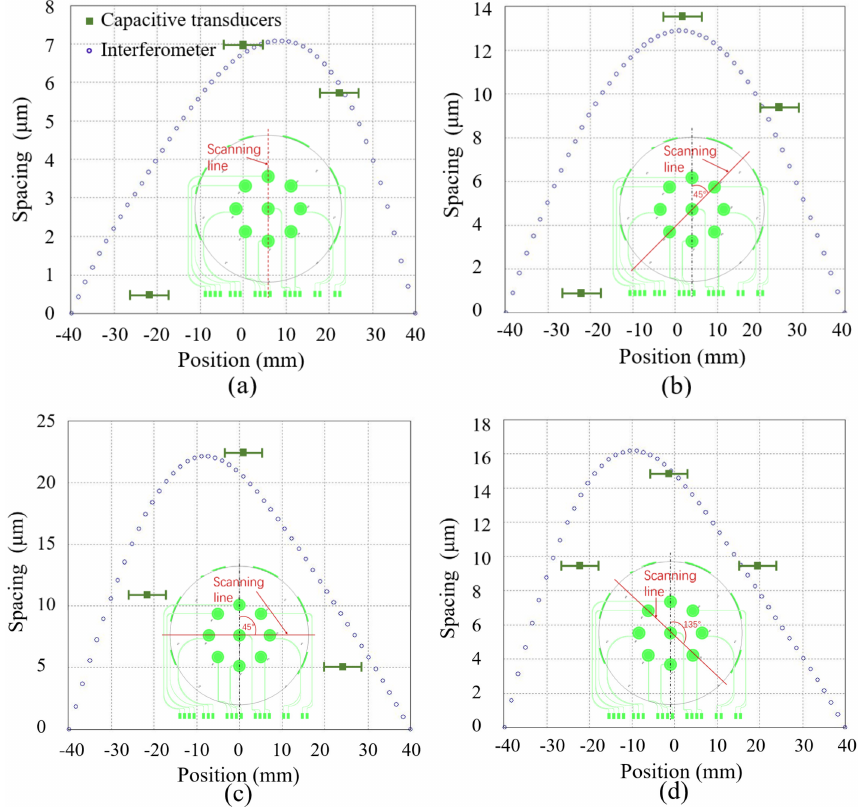
Figure 10. Measured wafer surface profile by the proposed capacitive transducers. The measurement results by a commercial film-stress interferometer are shown as a reference. ( a ) The scanning line is parallel to the reference line; ( b ) The angle between the scanning line and the reference line is 45 degrees; ( c ) The angle between the scanning line and the reference line is 90 degrees; ( d ) The angle between the scanning line and the reference line is 135